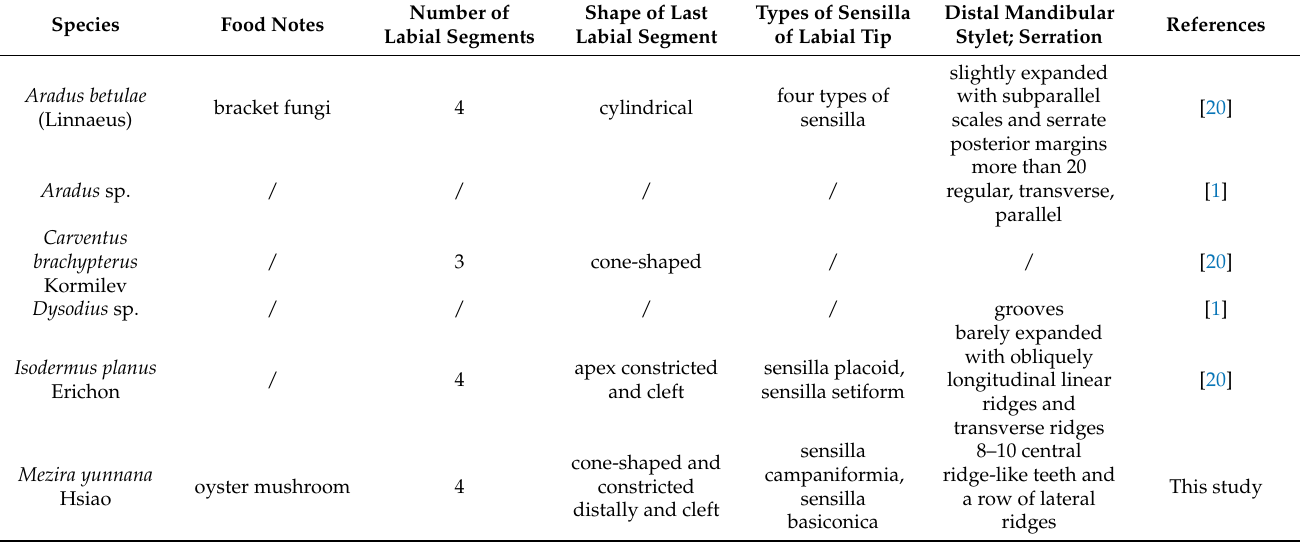
Table 4. Morphological characteristics of mouthparts and diet type of Aradidae